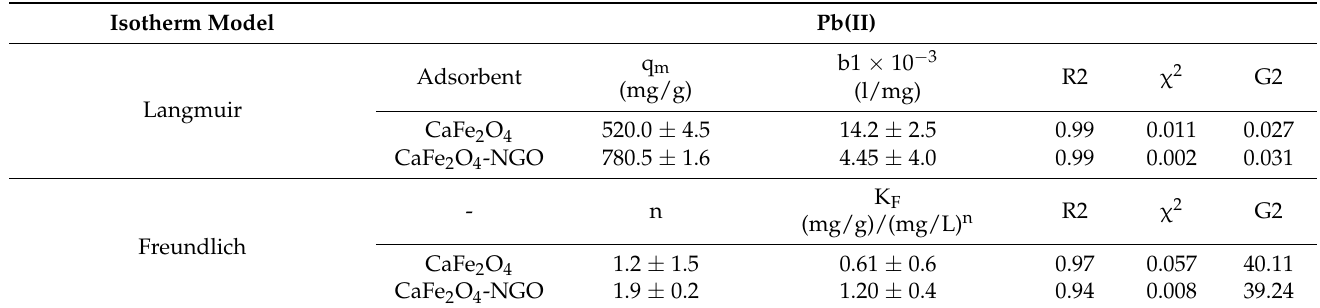
Table 5. Langmuir and Freundlich isotherm parameters and statistical analysis for adsorption of Pb(II) ions. Isotherm Model Pb(II)